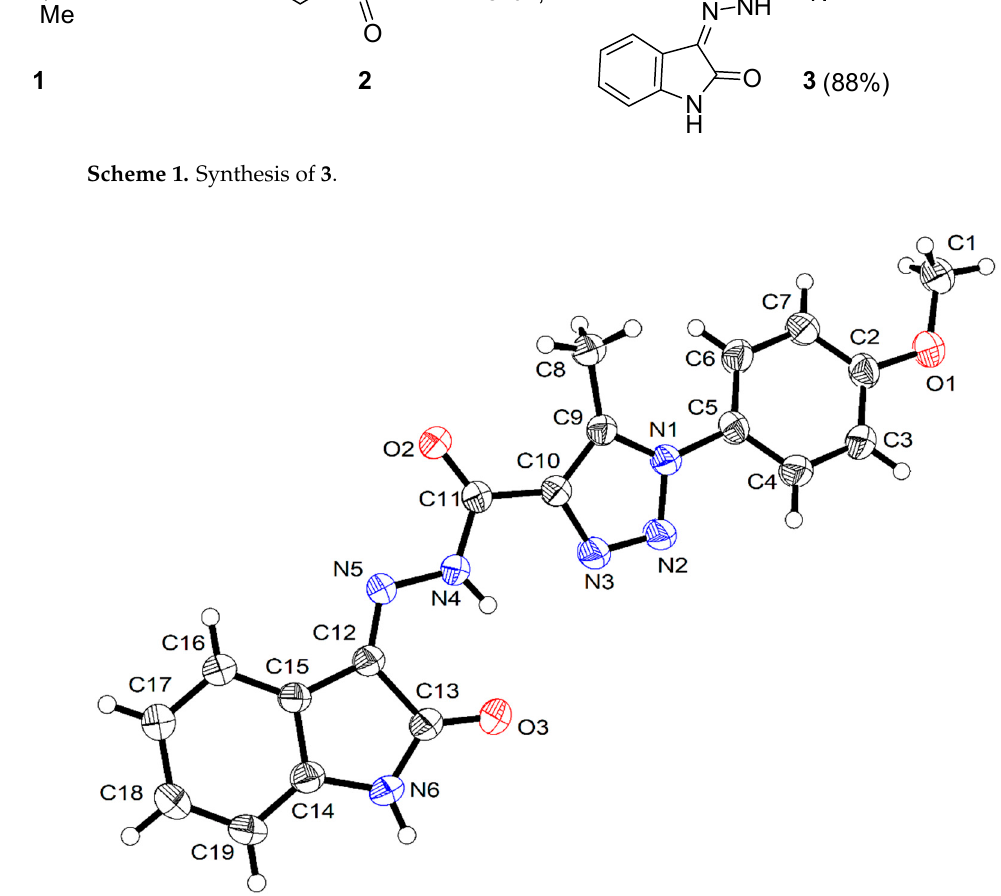
Figure 1. A molecule of 3 with atomic displacement ellipsoids represented at 50% probability.